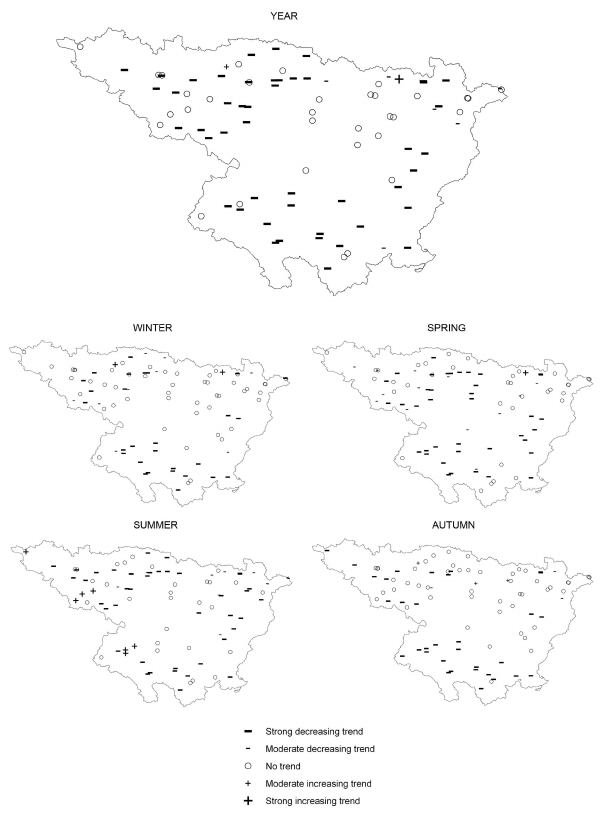
Fig. 4. Temporal evolution of river discharges.